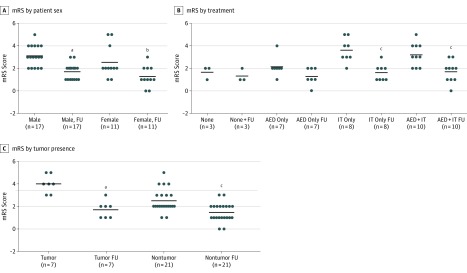
Modified Rankin Scale (mRS) Scores in 28 Patients With Neuromyotonia (NMT) Before and After TreatmentaA, Scores in male and female patients before treatment and at follow-up (FU). B, Scores before treatment and at FU according to treatment type. Further information on treatment responses is given in eTable 4 in the Supplement. C, Scores in patients with tumors (3 thymomas, 3 prostate tumors, and 1 acute lymphocytic leukemia after bone marrow transplant) and without tumors. In most cases, mRS scores were lower at FU (2-tailed paired t tests). The mRS measures disability on a range of 0 to 6, with 0 indicating normal and 6 indicating death. Solid horizontal lines indicate means. P values were determined by 2-tailed t test. AED indicates antiepileptic drugs and other symptomatic therapies; IT, immunotherapy.aP < .001 for the change in mRS score at FU.bP = .02 for the change in mRS score at FU.cP = .001 for the change in mRS score at FU.